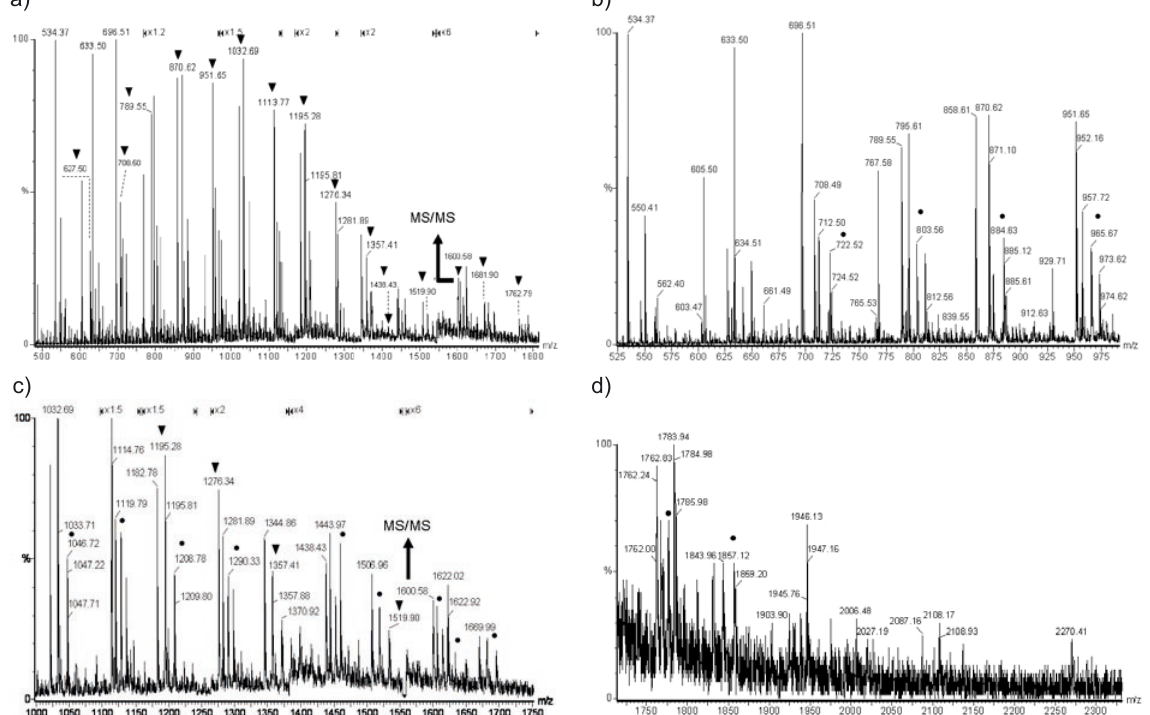
Figure 3. Positive nanoESI Q-TOF MS of HMD-modified maltodextrin mixture. a) m/z (500 - 1800); b) m/z (525 - 975); c) m/z (1000 - 1750); d) m/z (1725 - 2300). Capillary voltage: 1.2 kV. Cone voltage: 30 - 60 V. Acquisition: 850 scans. ▼ -Gl